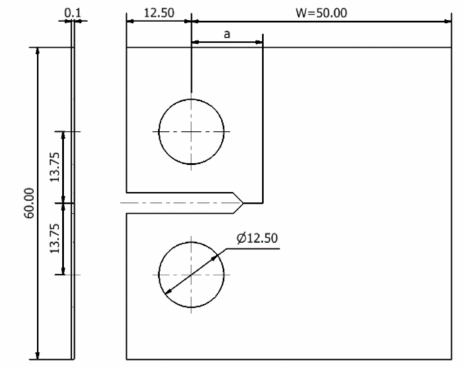
Figure 1. Compact tension specimen used to model AA2024-T351, with dimensions in mm. The finite element mesh of the specimen (Figure 2) is composed by three distinct zones: a very refined area near the crack tip, a transition zone, and a coarser mesh in the far side of the crack zone. The more refined zone considers a rectangular box with elements of 8 × 8 µ m 2 , allowing an accurate prediction of the stress and strain fields at the crack tip zone [37]. On the other hand, the coarser zone allows to reduce the computational cost. In the end 7287 linear hexahedral finite elements and 14,918 nodes were used.